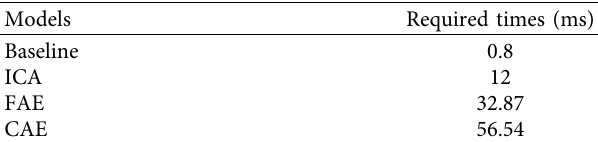
Table 7: Required time to extract the condition-invariant features of a test